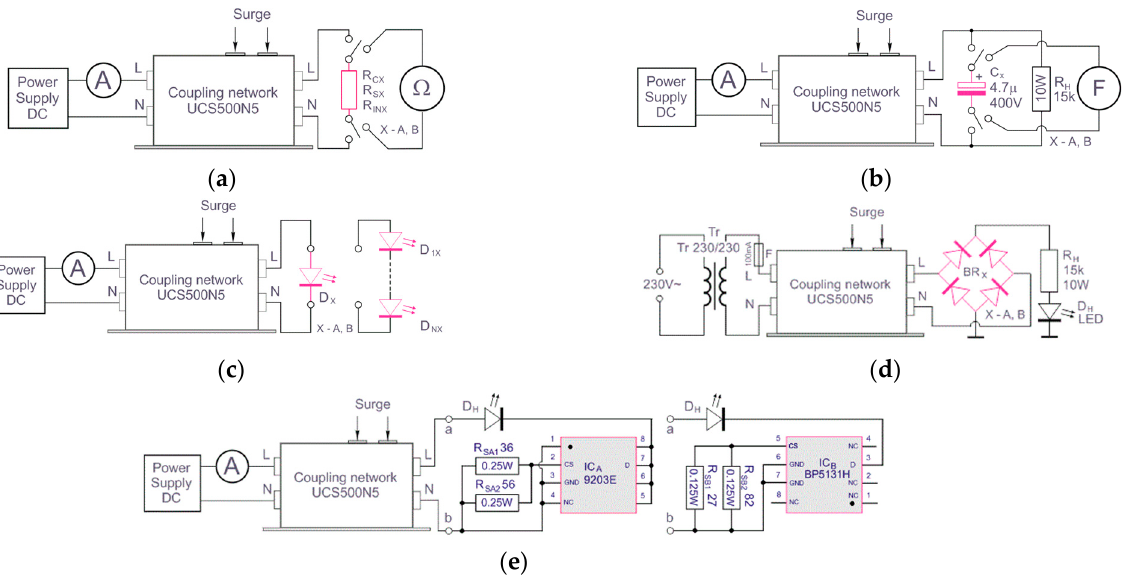
Figure 5. Configurations of test systems for measuring the immunity of elements to a surge of 1.2/50 µs (8/20 µs): ( a ) resistors, ( b ) capacitors, ( c ) diodes, ( d ) rectifier bridge, ( e ) current stabilizer.